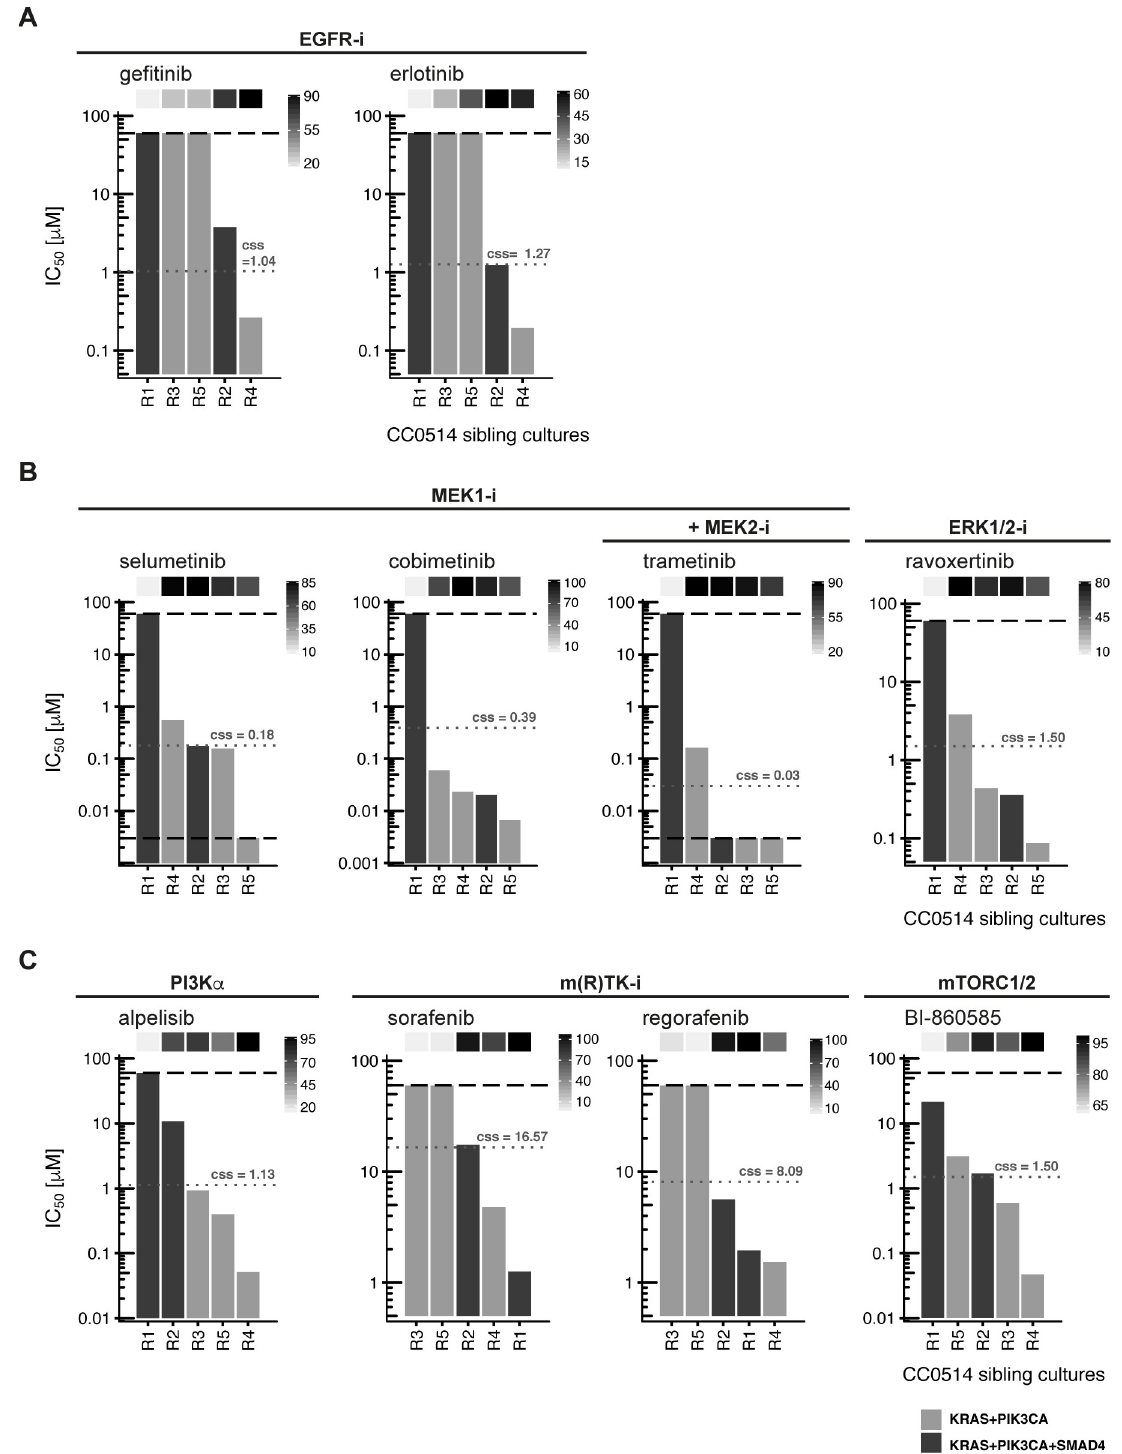
Fig 5. Organoid sibling cultures display heterogeneous drug responses. IC 50 values for sibling cultures derived from patient tumor CC0514 treated with a panel of small molecules targeting EGFR, MEK/ERK, PI3K α , mTORC1/2 and multiple kinases are shown. The lower and upper assay cutoffs were 0.003 μ M and 60 μ M. Drug efficacy (E max ) was included as additional parameter of response, indicated with light grey to black boxes above the waterfall plot according to percent efficacy. Critical mutations in each culture are depicted in light and dark grey bars according to the legend at the bottom of the figure. Achievable steady state in vivo plasma concentrations (c ss ) are given